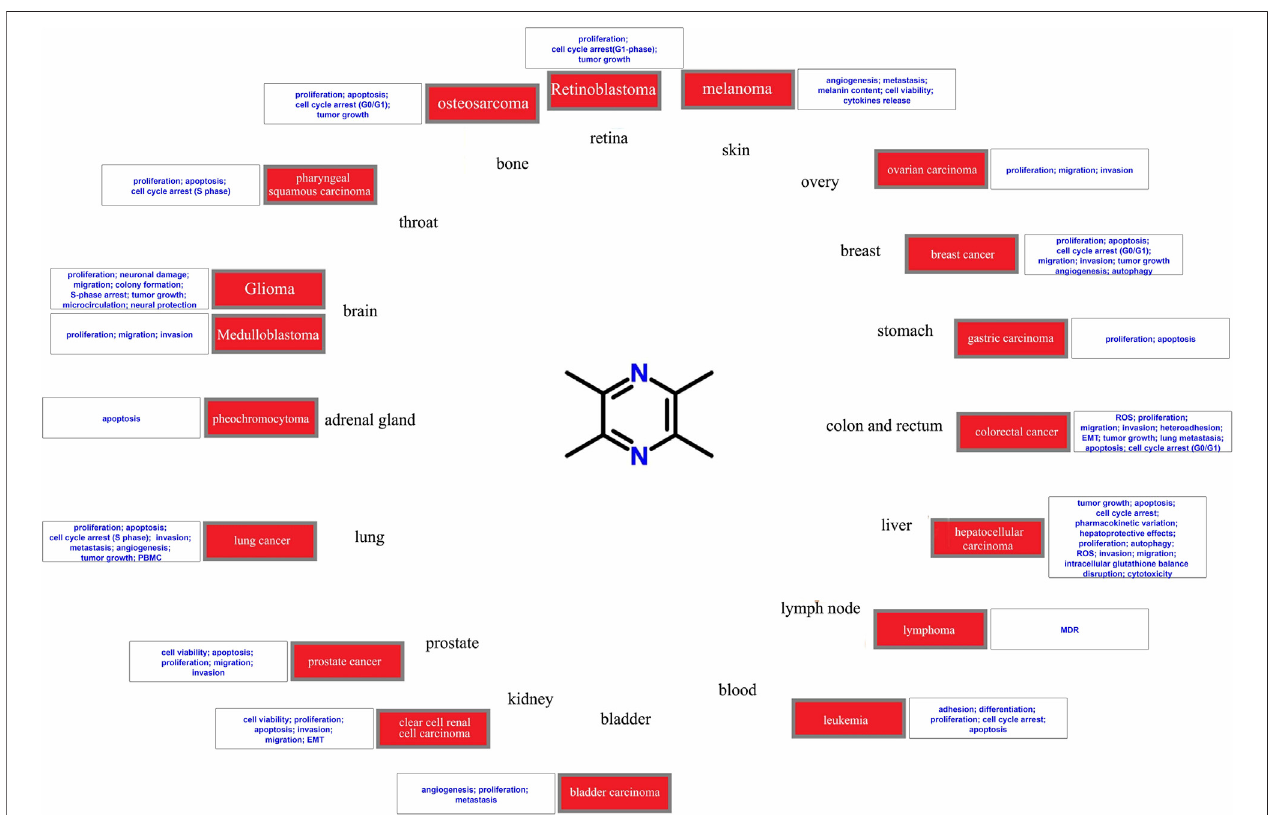
FIGURE 2 | Diseases involved in the current study of the antitumor potential of tetramethylpyrazine.